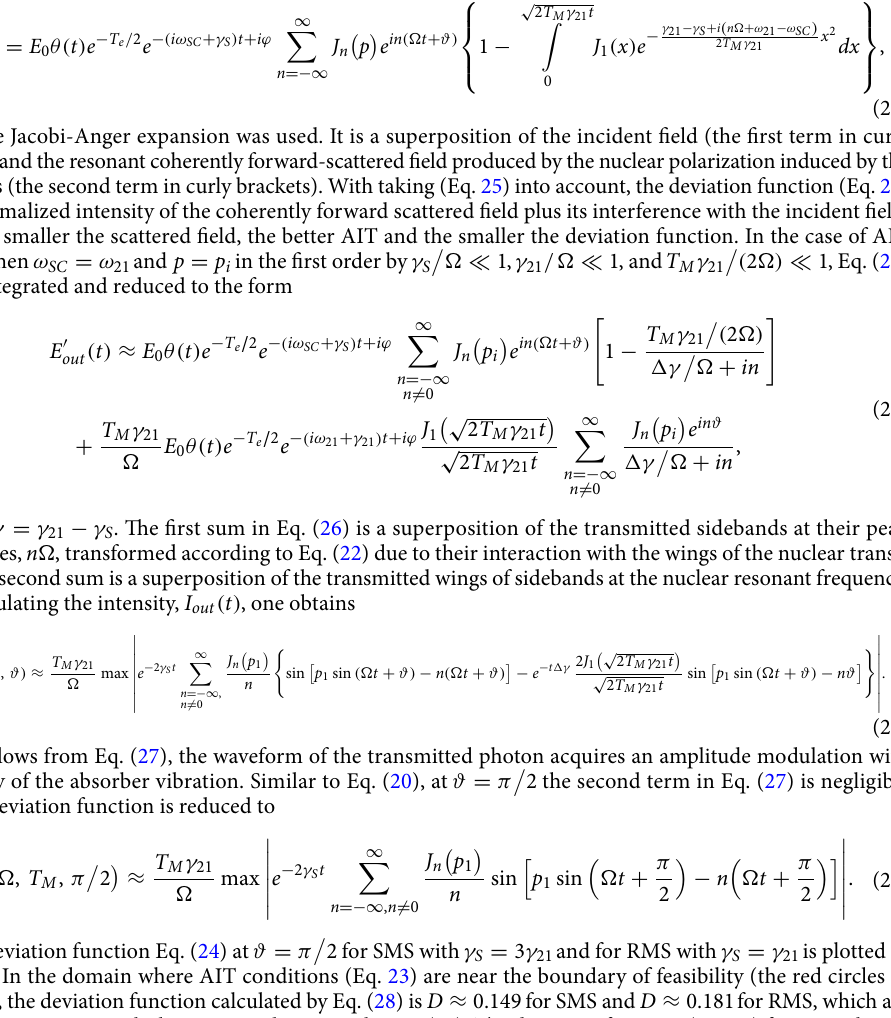
( 2 �) 1 , it can be esti- ≪